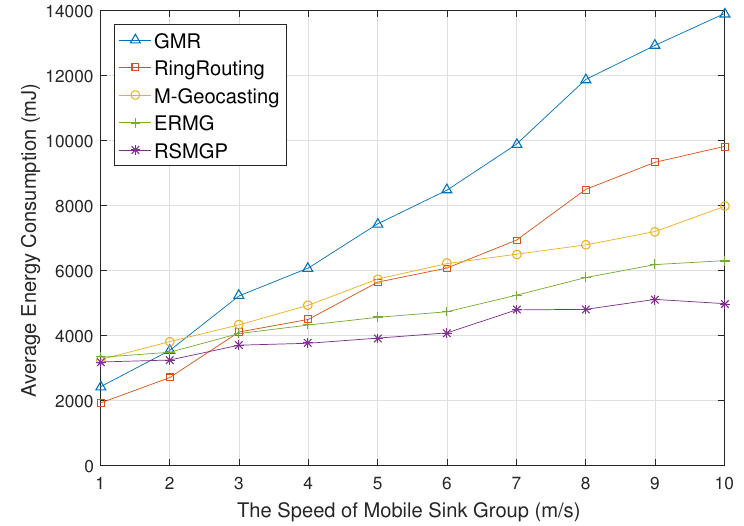
Figure 8. Energy consumption impacted by moving speed of a sink